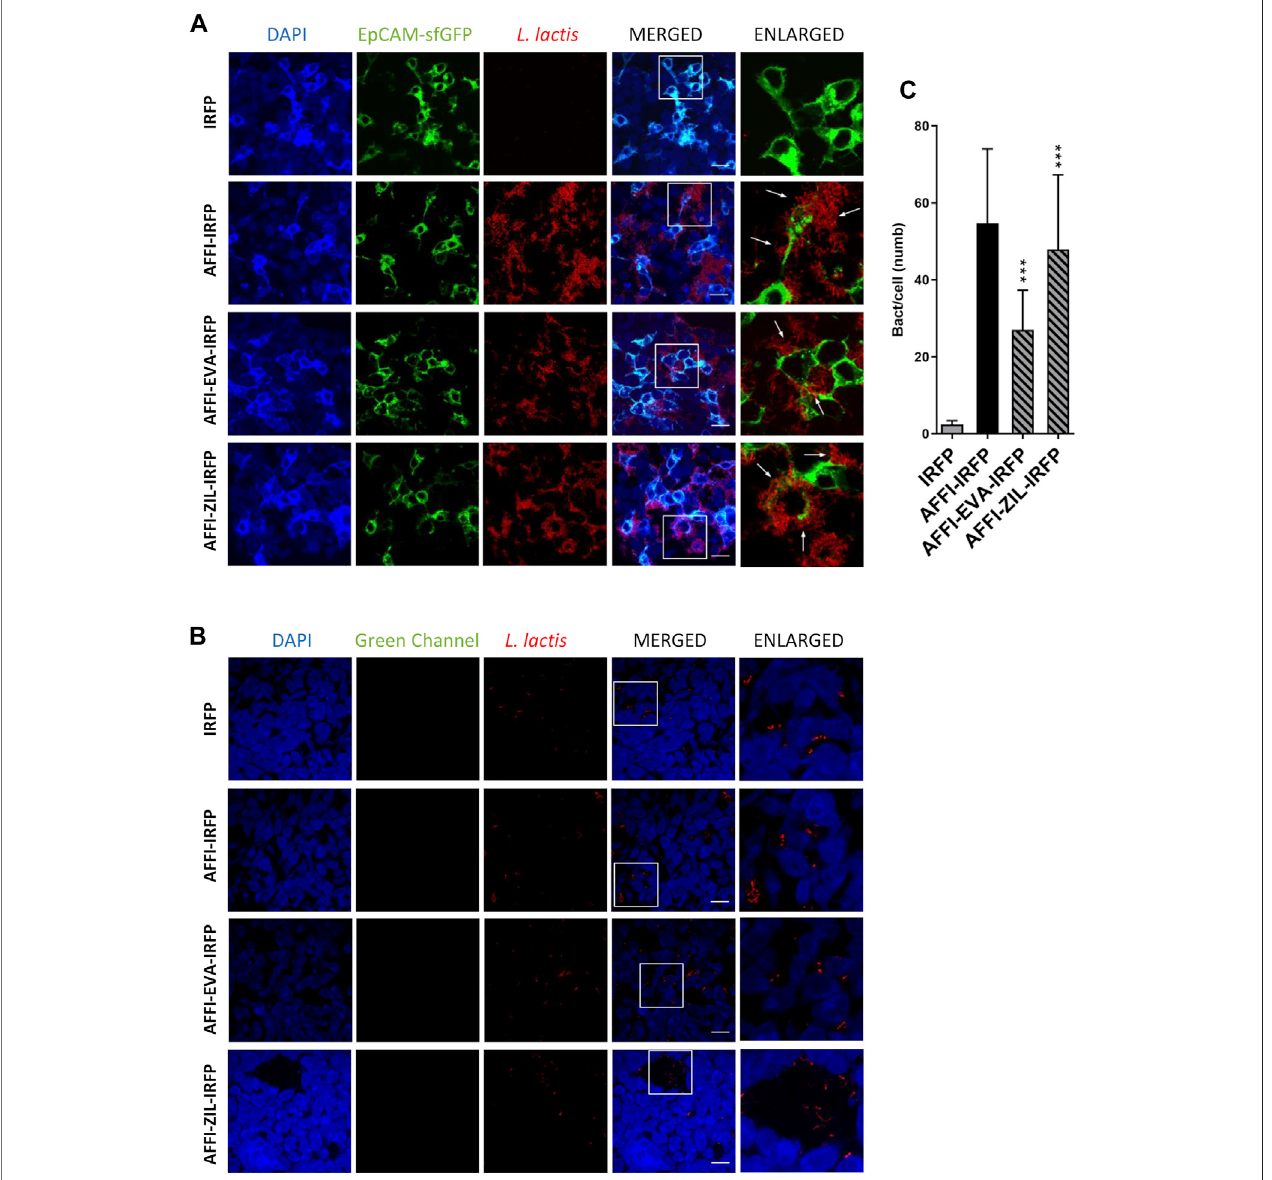
FIGURE 7 | The engineered L. lactis strongly and selectively adheres to EpCAM-overexpressing HEK293 cells. Representative confocal microscopy images of adhesion of AFFI co-expressing L. lactis to HEK293 cells transfected with EpCAM (A) or to nontransfected HEK293 cells (B) . Images were quanti fi ed by determining the number of adhered bacteria per HEK293 cell in 10 representative micrographs for each experimental condition, using ImageJ (C) . L. lactis strains tested: L. lactis -AFFI-EVA-IRFP ( L. lactis co-expressing AFFI, EVA, and IRFP); L. lactis -AFFI-ZIL-IRFP ( L. lactis co-expressing AFFI, ZIL, and IRFP); L. lactis -AFFI-IRFP ( L. lactis co-expressing AFFI and IRFP; positive control); and L. lactis -IRFP ( L. lactis expressing IRFP only; negative control). DAPI, DAPI channel showing HEK293 cell nuclei; HEK293-EpCAM-sfGFP, green fl uorescence channel showing superfolder green fl uorescent protein (sfGFP)-labeled EpCAM overexpressed on the surfaces of the HEK293 cells; L. lactis , red fl uorescence channel showing L. lactis . Enlarged images show attachment of L. lactis to transfected HEK293 cells with characteristic adhesion pattern (arrows). White squares indicate the enlarged sections of the images. Scale bars, 20 μ